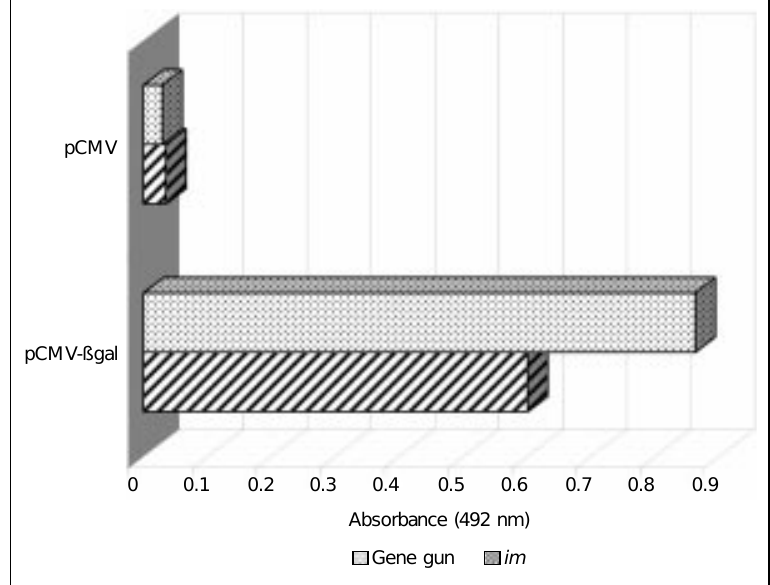
Figure 1 - Analysis of the immune responses induced in BALB/c mice following gene vaccination with pCMV-ßgal plasmid by gene gun or im injection. Mice (ten per group) were injected with cardiotoxin (10 mM) ten days prior to im vaccination with 100 µg of plasmid DNA into the quadriceps muscles. For gene gun immunization, animals were bombarded on the shaved abdomen with two shots per animal (below 0.5 µg of DNA per shot). Using both methods, mice were vaccinated three times at two-week intervals. The control group received pCMV plasmid DNA without the gene coding for ß-gal. On day 45, animals were bled and total IgG anti-ß-galactosidase were measured by indirect ELISA. Results are reported as mean values of